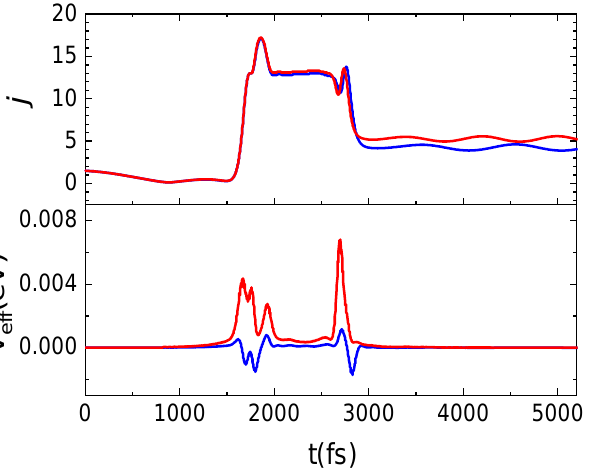
Figure 10. Time evolution for j and V eff (see text) for the same trajectory propagated at T S = 100 K (blue lines) and T S = 1000 K (red lines) for N 2 (0,1) and E coll = 0.06 eV.